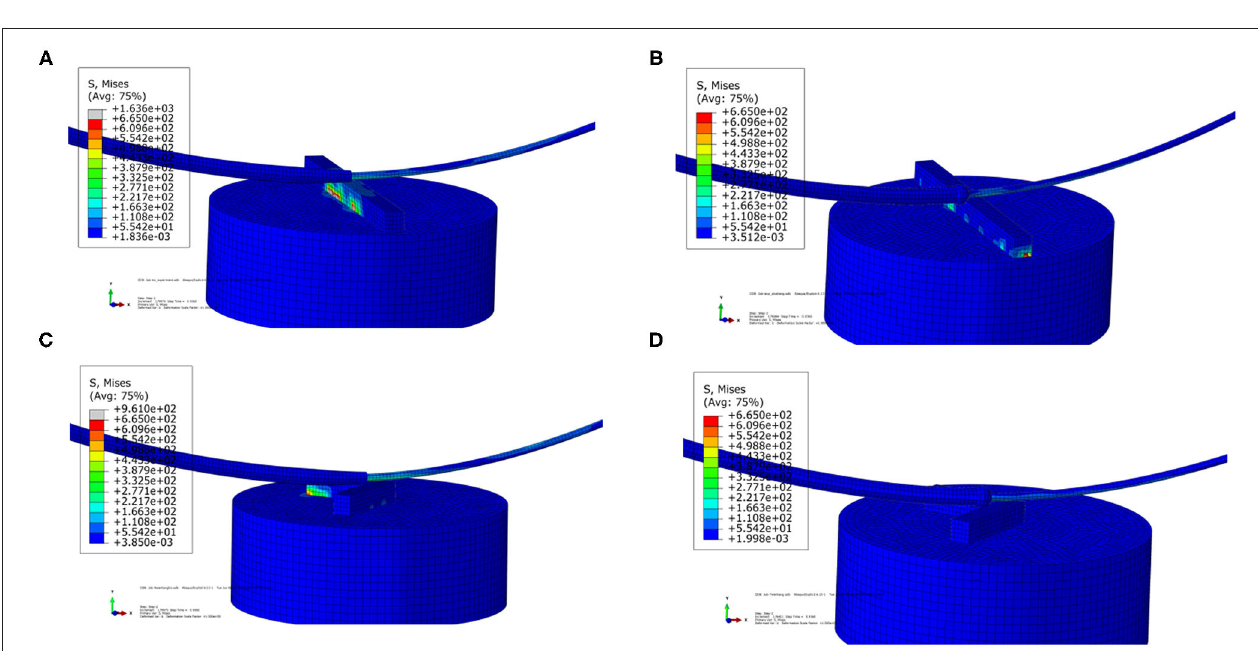
FIGURE 8 | Visualizations of simulation results of the experimental FEA model. (A) Traditional catheter with straight strut model, (B) spherical-tip catheter with straight strut model, (C) traditional catheter with slanted strut model, and (D) spherical-tip catheter with slanted strut model.